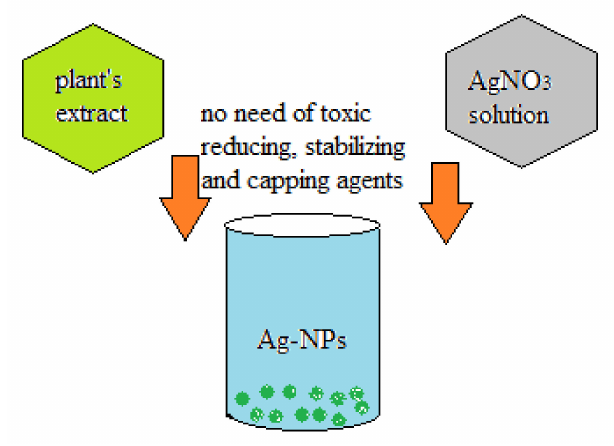
Figure 3. Green synthesis of